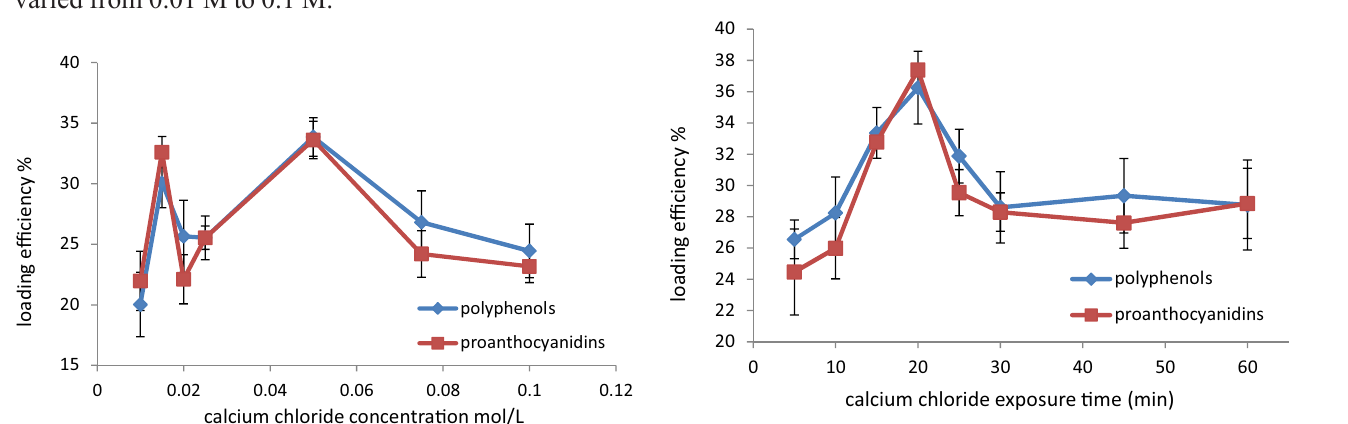
FIGURE 2 - Effect of calcium chloride concentration on total extractable polyphenols and proanthocyanidins loading efficiency. a Values are mean ± SD, (n = 3).